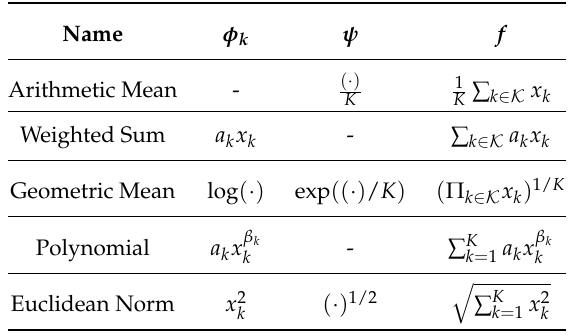
Table 1. Examples of the objective functions